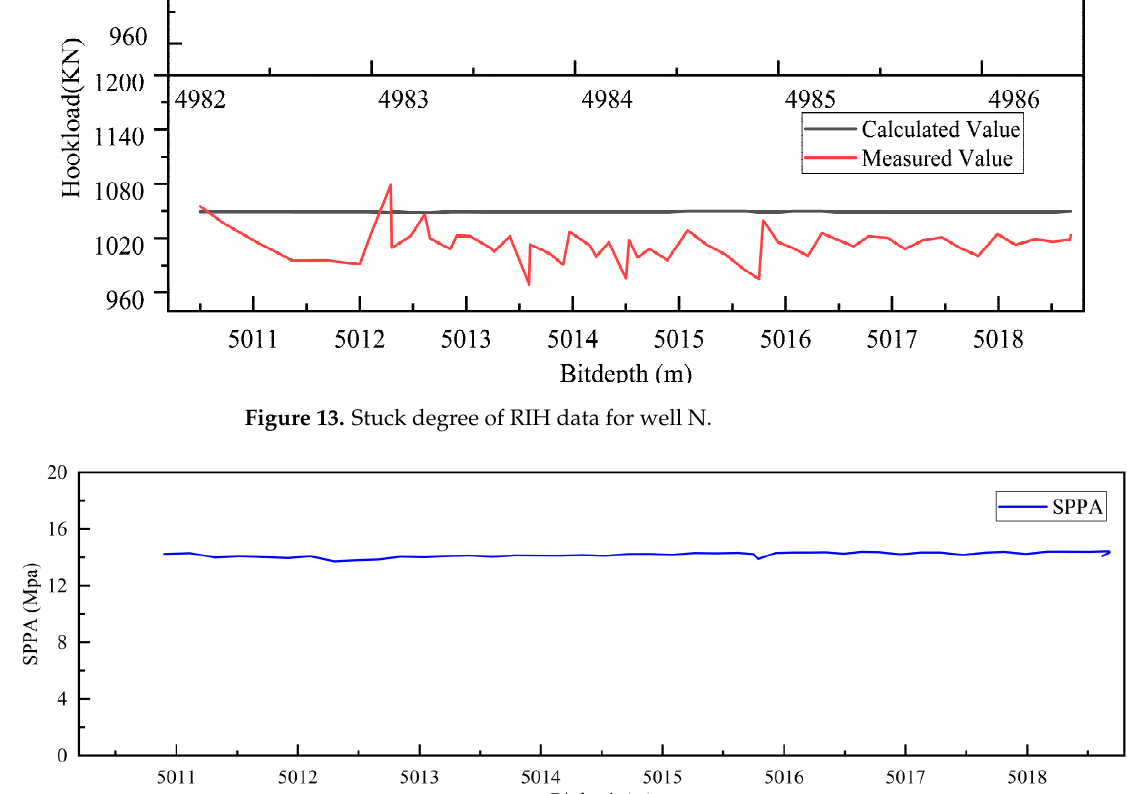
Table 11. Recognition results of the stuck data from 4:55 to 5:05 using SAX method Stuck Characteristics